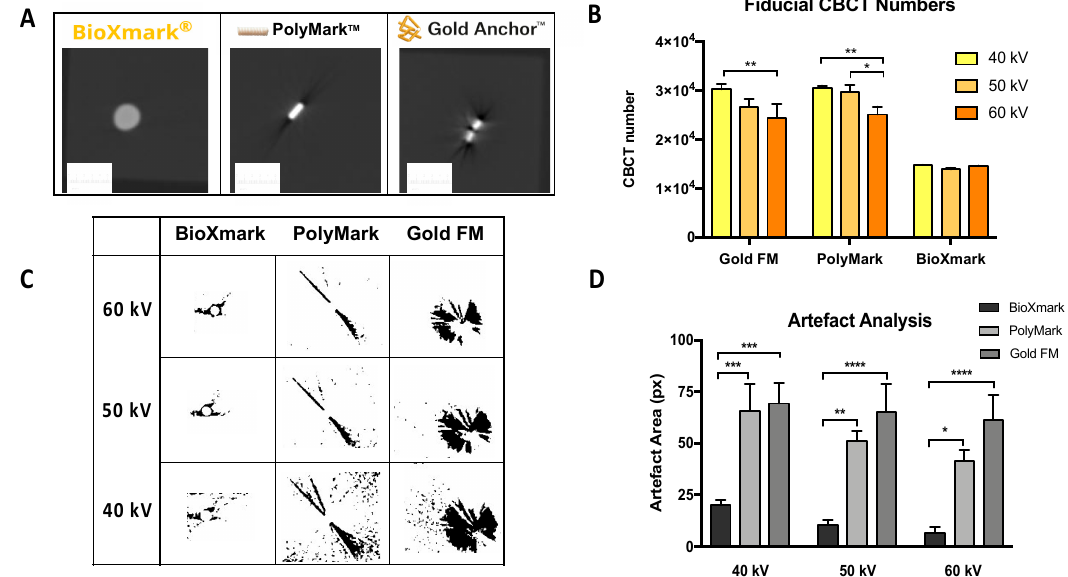
Figure 1. In phantom analysis of CBCT visibility and imaging artefacts for BioXmark ® and solid fiducial markers. ( A ) Representative imaging of BioXmark ® (20 µL), polymer and gold fiducial markers and corresponding CBCT numbers at imaging energies of 40, 50 and 60 kV ( B ). ( C ) Analysis of imaging artefacts on CBCT images processed using ImageJ and presented at imaging energies of 40, 50 and 60 kV ( D ). Data presented are mean values ± standard error (SEM); statistical significance is reported as * > 0.05, ** > 0.01, *** 0.0001, **** > 0.0001 .